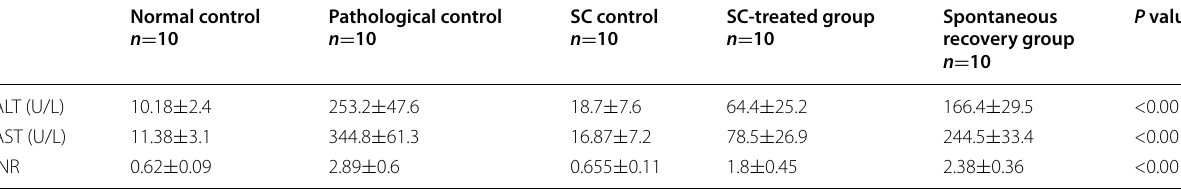
Table 1 Estimation of serum ALT, AST, and INR levels among studied groups